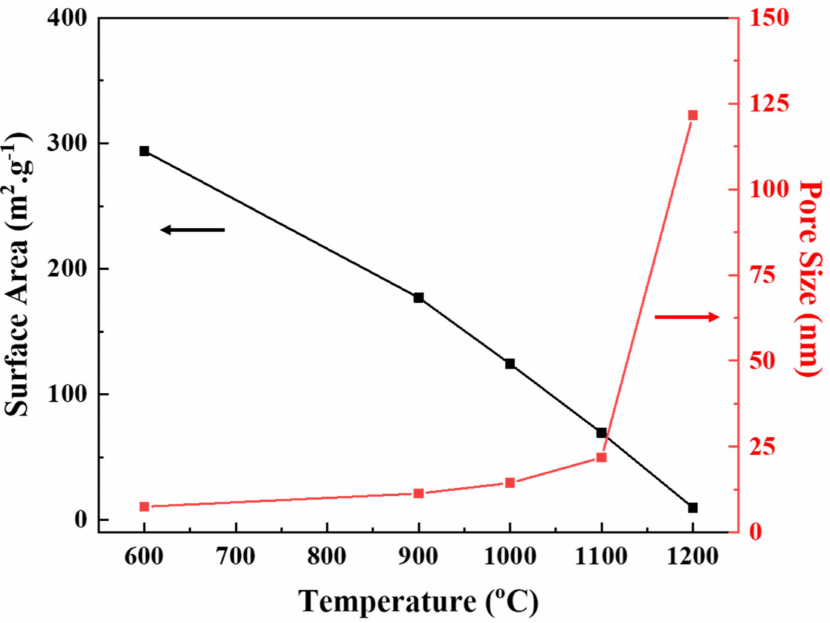
Figure 9. Effect of different sintering temperatures on the surface area and pore-size distributions of the Al 2 O 3 membranes.